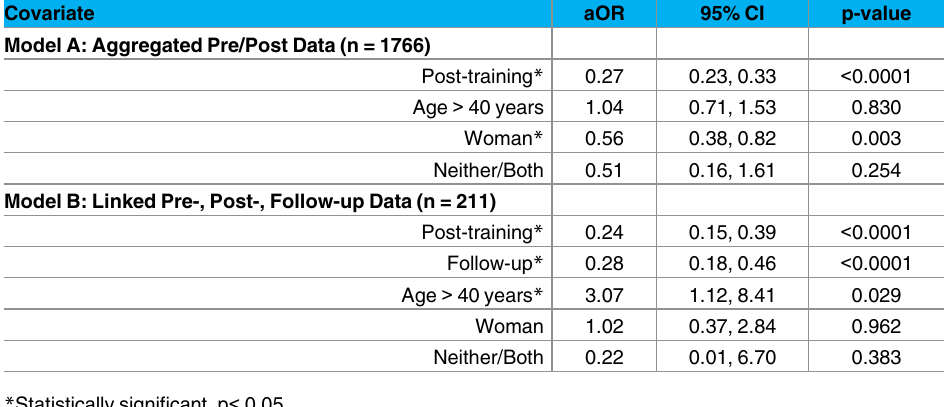
Table 5. Multivariable ordinal logistic regression models of factors associatedwith attitudes toward gender and sexual minorities. Covariate aOR 95% CI